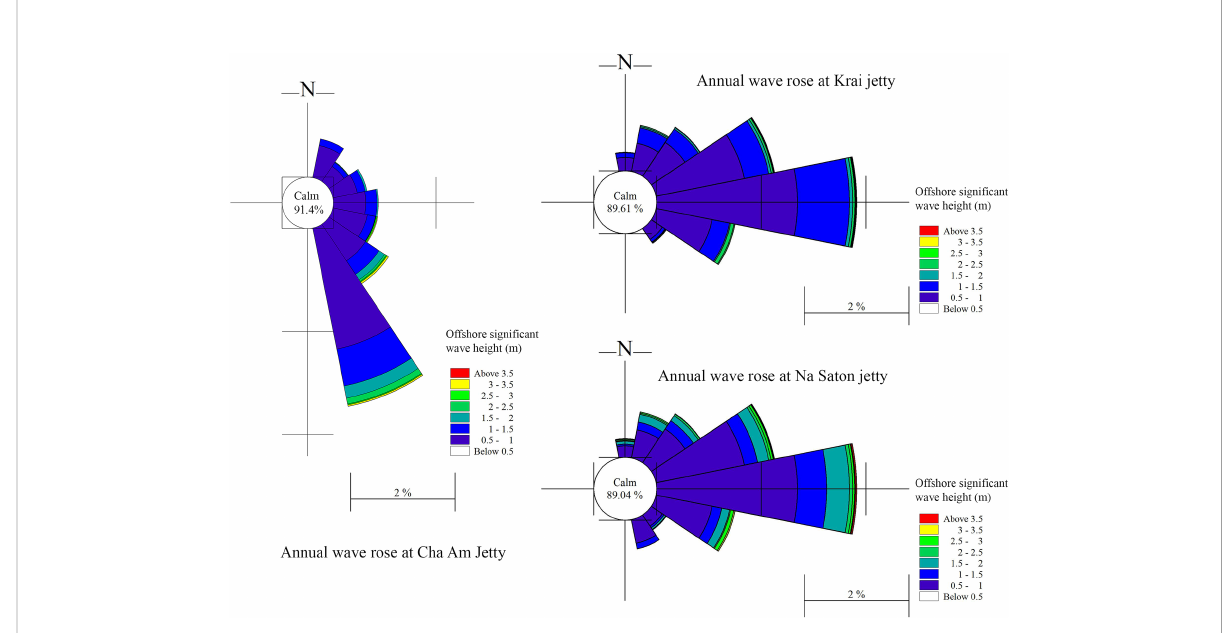
FIGURE 3 Annual wave rose at the jetties in this